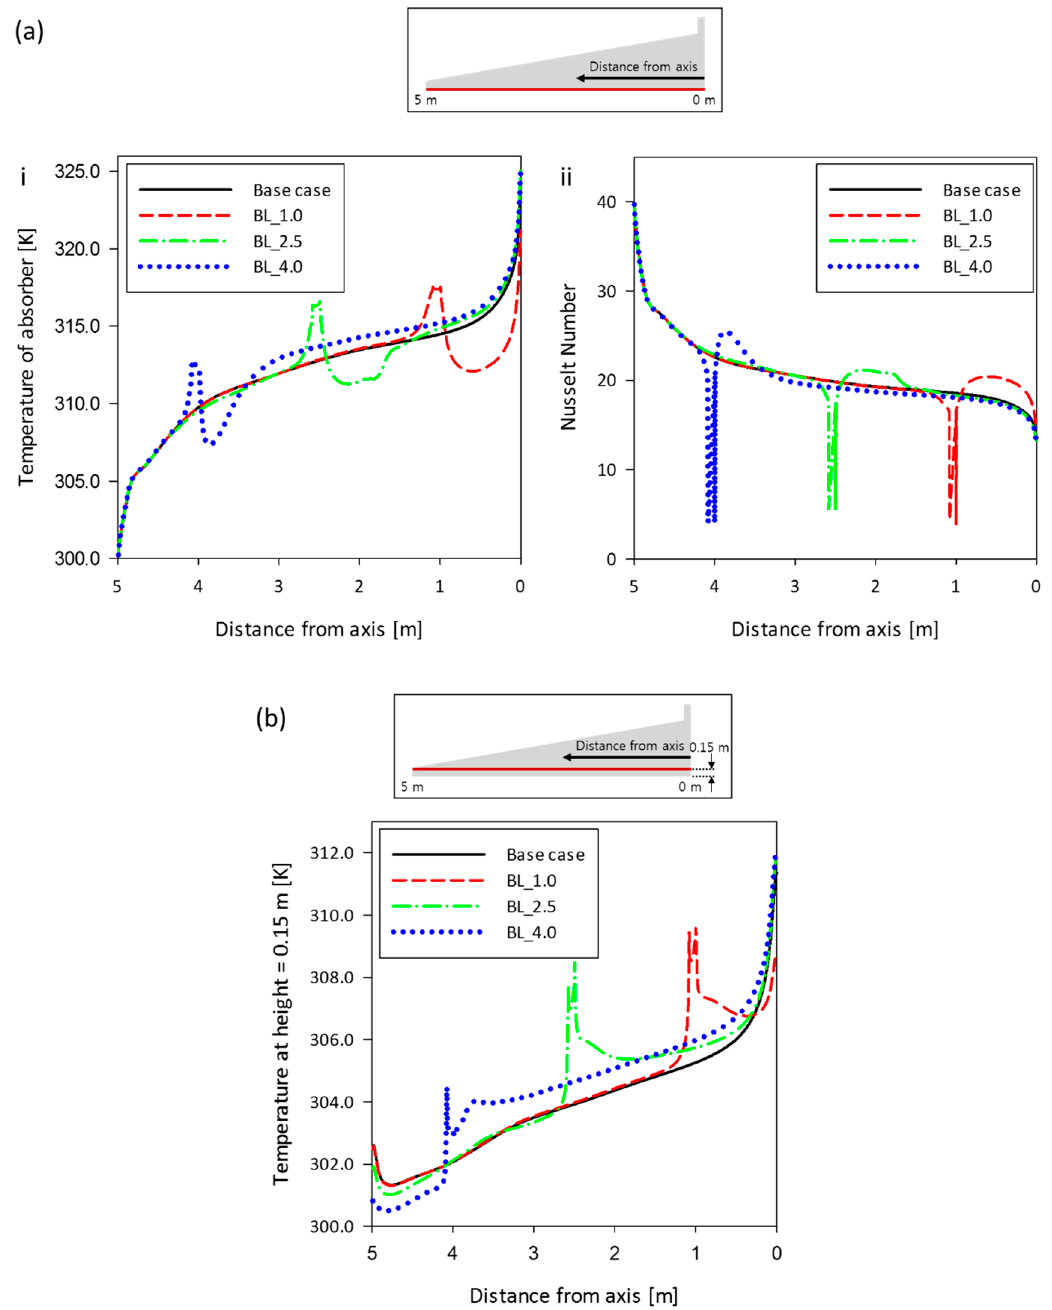
Figure 4. The effect of the installation location of the baffle. ( a ) The profiles at the absorber (h = 0 m, marked as a red line in the inset above): (i) The temperature profile and (ii) the Nusselt number profile. ( b ) The temperature profiles at the tip height of the baffle (h = 0.15 m, marked as a red line in the inset above) changed significantly near the baffle and its downstream.